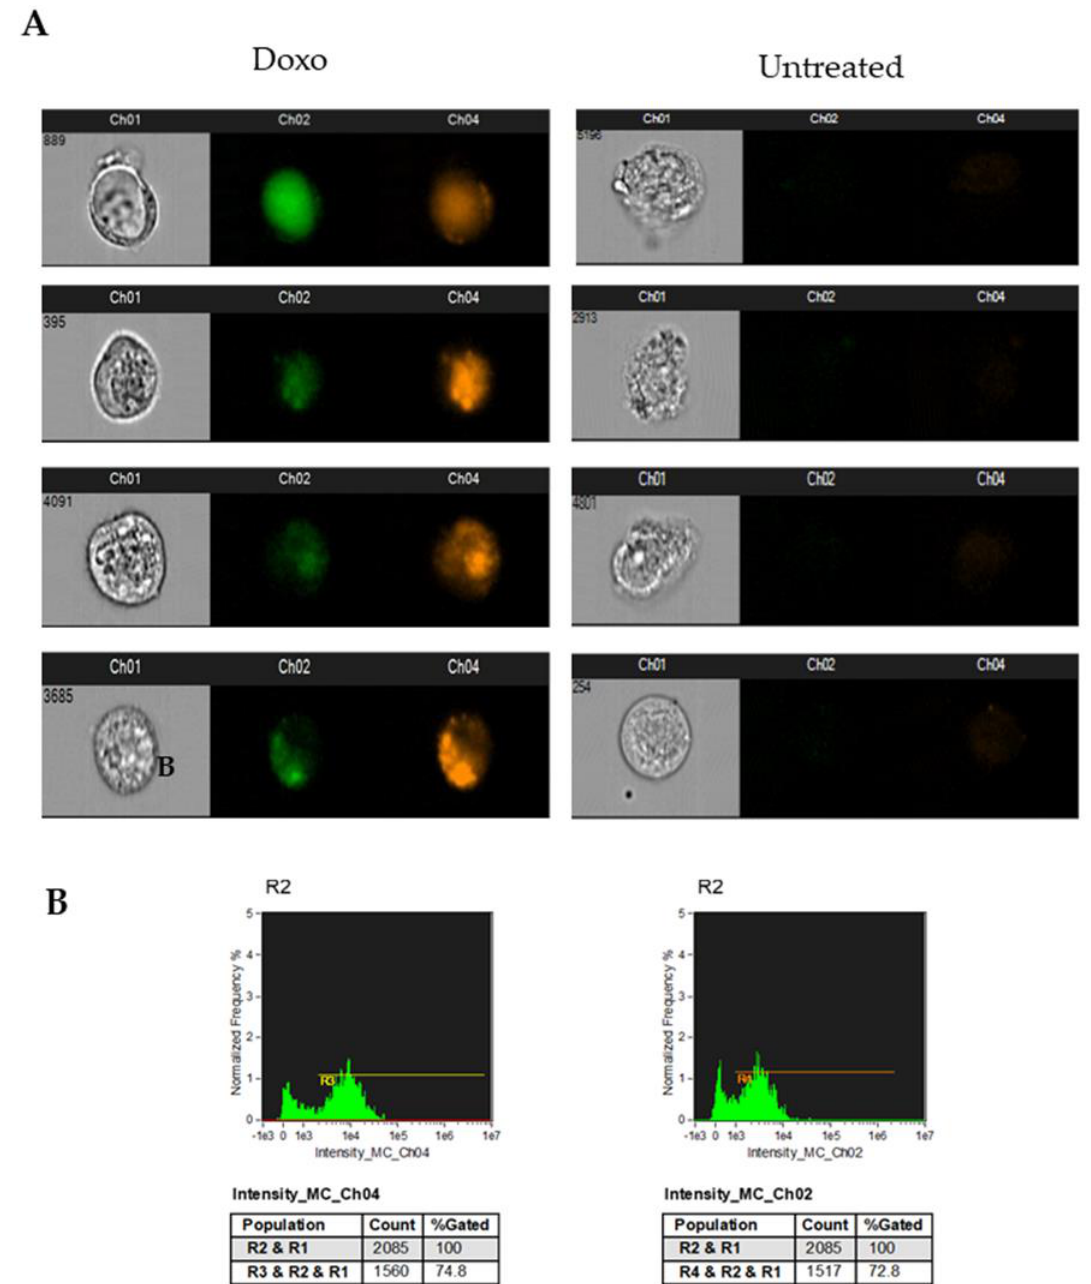
Figure 3. Analysis of doxorubicin fluorescence emission with ImageStream. MDA-MB-231 cells treated for 24 h with 1 µ M doxorubicin were acquired using ImageStream: ( A ) representative images of treated cell brightfield and fluorescence detected in channel 1 (FITC and analogue fluorochromes) and channel 4 (propidium iodide and analogue fluorochromes) for representative cells treated with doxorubicin (Doxo) or untreated are shown; ( B ) histograms represent doxorubicin autofluorescence detected in channel 1 (FITC and analogue fluorochromes) and channel 4 (propidium iodide and analogue fluorochromes). Data are representative of three independent experiments.